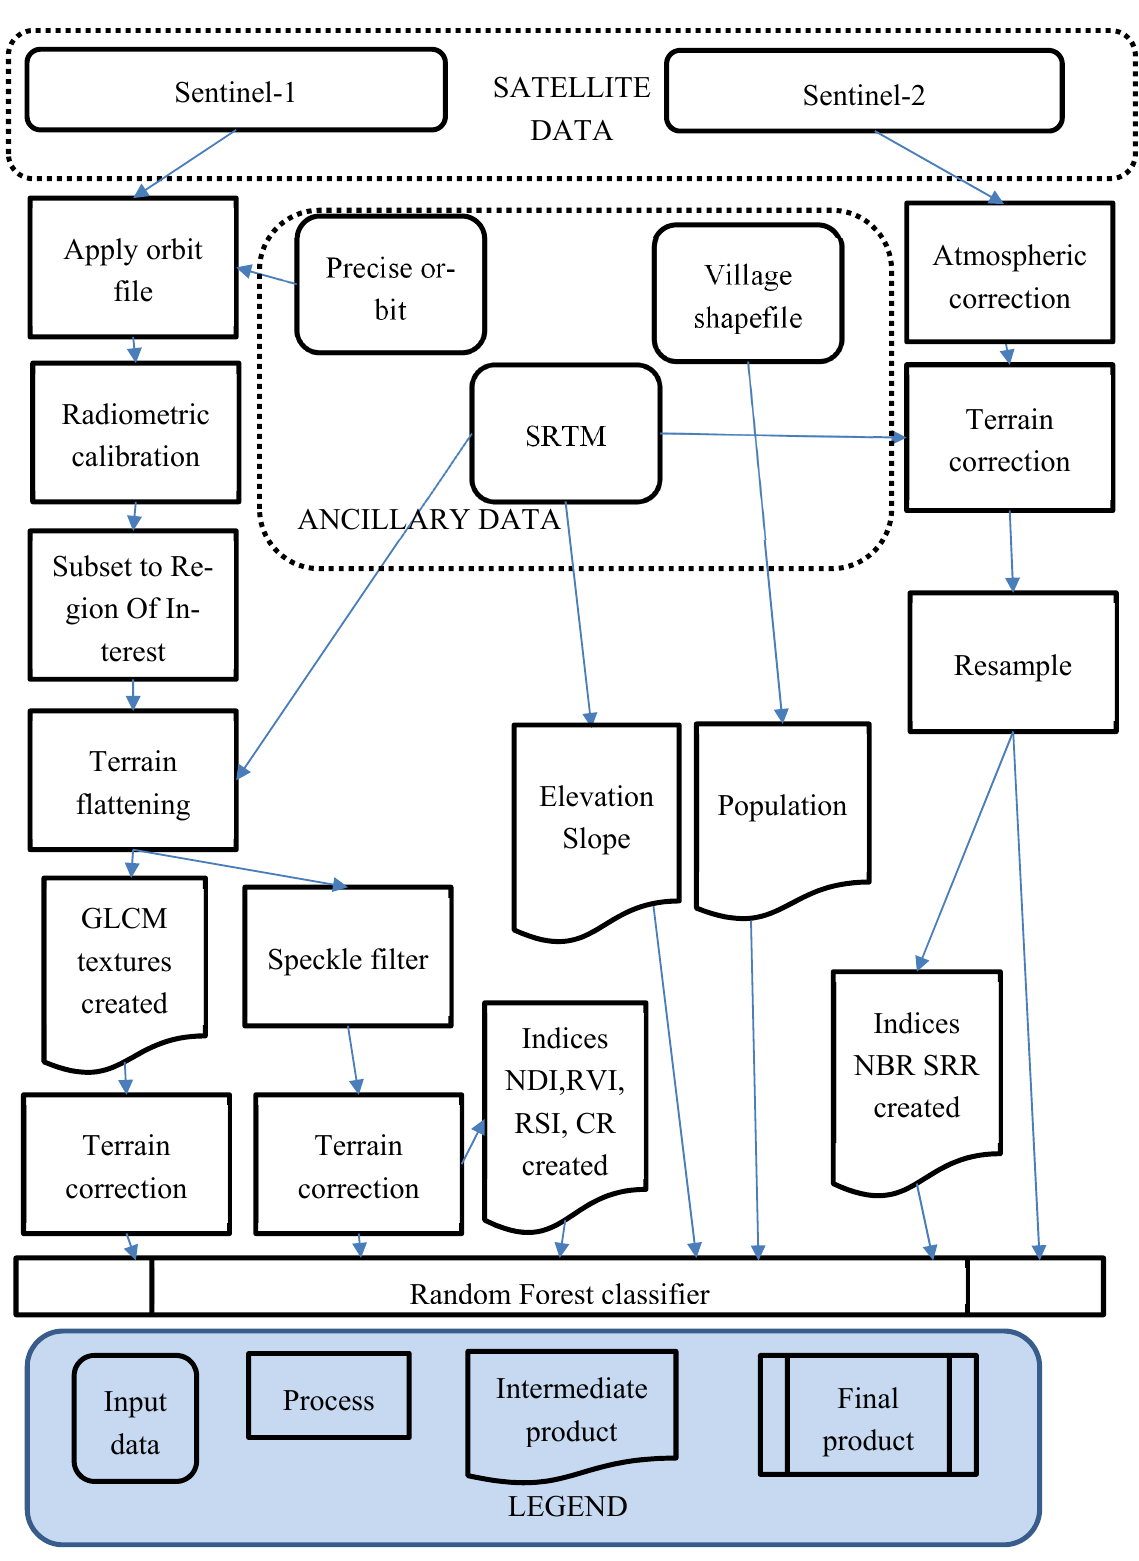
Figure 2. Flowchart of pre-processing carried out on Sentinel images. Abbreviations: GLCM: Grey–Level Co-Occurrence Matrix, SRTM: Shuttle Radar Topography Mission, NDI: Normalised Difference Index, RVI: Radar Vegetation Index, RSI: Radar Squared Index, CR: Cross-Ratio, NBR: Normalised Burn Ratio, SRR: Short-wave Infrared-Red Ratio.